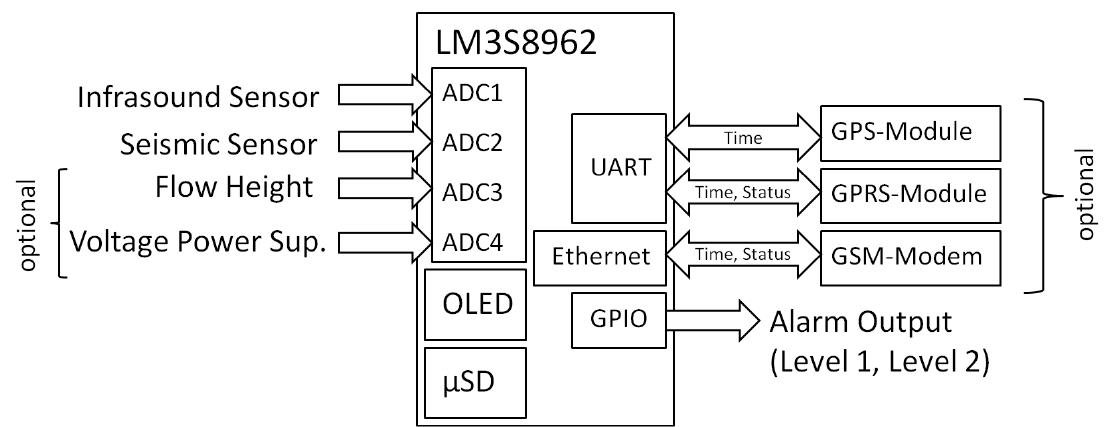
Figure 1. Overview system setup and